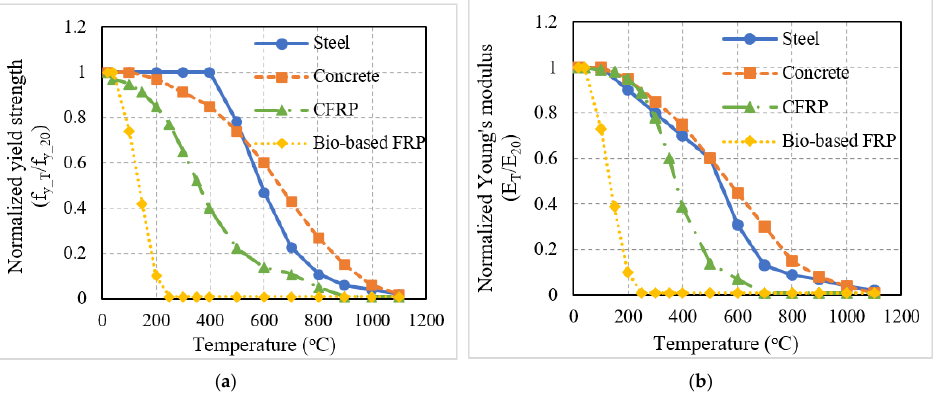
Figure 2. Variation of normalized yield strength and elastic modulus of steel, concrete, conventional FRP (CFRP), and bio-based FRP. ( a ) Yield strength; ( b ) elastic modulus.